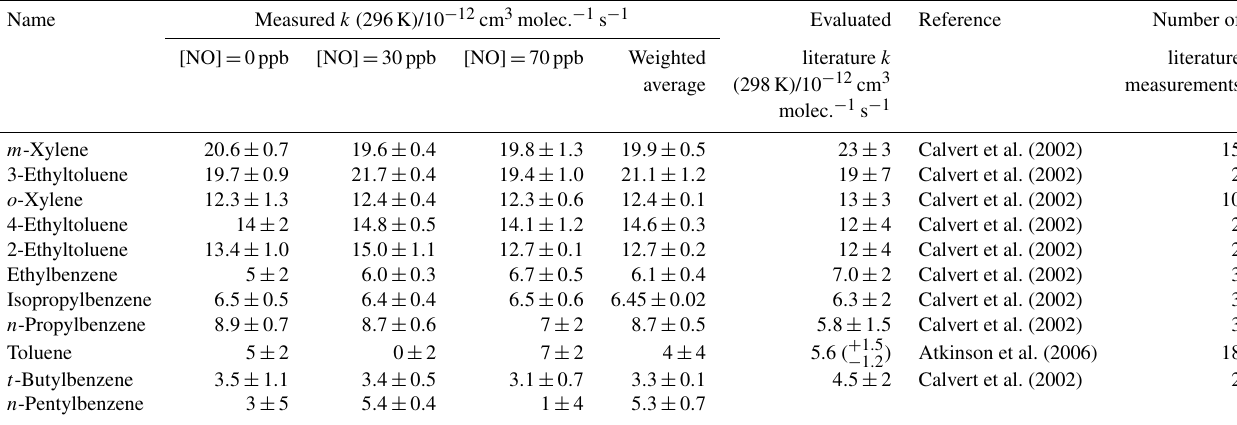
Table 2. Results of relative rate experiments, with evaluated literature data, for each VOC in Mixture 2, ordered by evaluated literature k value. The results of experiments using different concentrations of NO are presented, along with a mean measured k value for each VOC, weighted to the errors in the individual NO experiments. Each iteration with a different [NO] comprised three individual experiments with different OH reactivities of mixture injected into the reactor. Figure S3 shows the relative rate plots for Mixture 2 with an OH reactivity (in the reactor) of 18s − 1 and NO concentrations of 0, 30, and